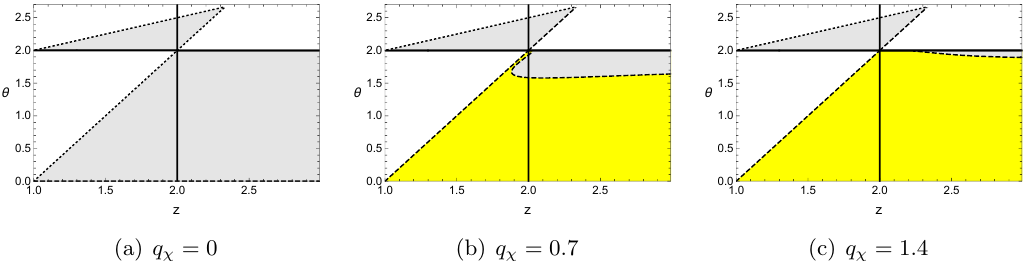
Figure 19 . WL vs WAL in the longitudinal resistivity. They are determined by the sign of the coe(cid:14)cient of q 2 near q 2 = 0. Yellow region denotes positive sign(WL) and gray region is for negative 2 sign(WAL). Dotted line is NEC. Here we use the same parameters as (cid:12)gure 18 and T = 0 :